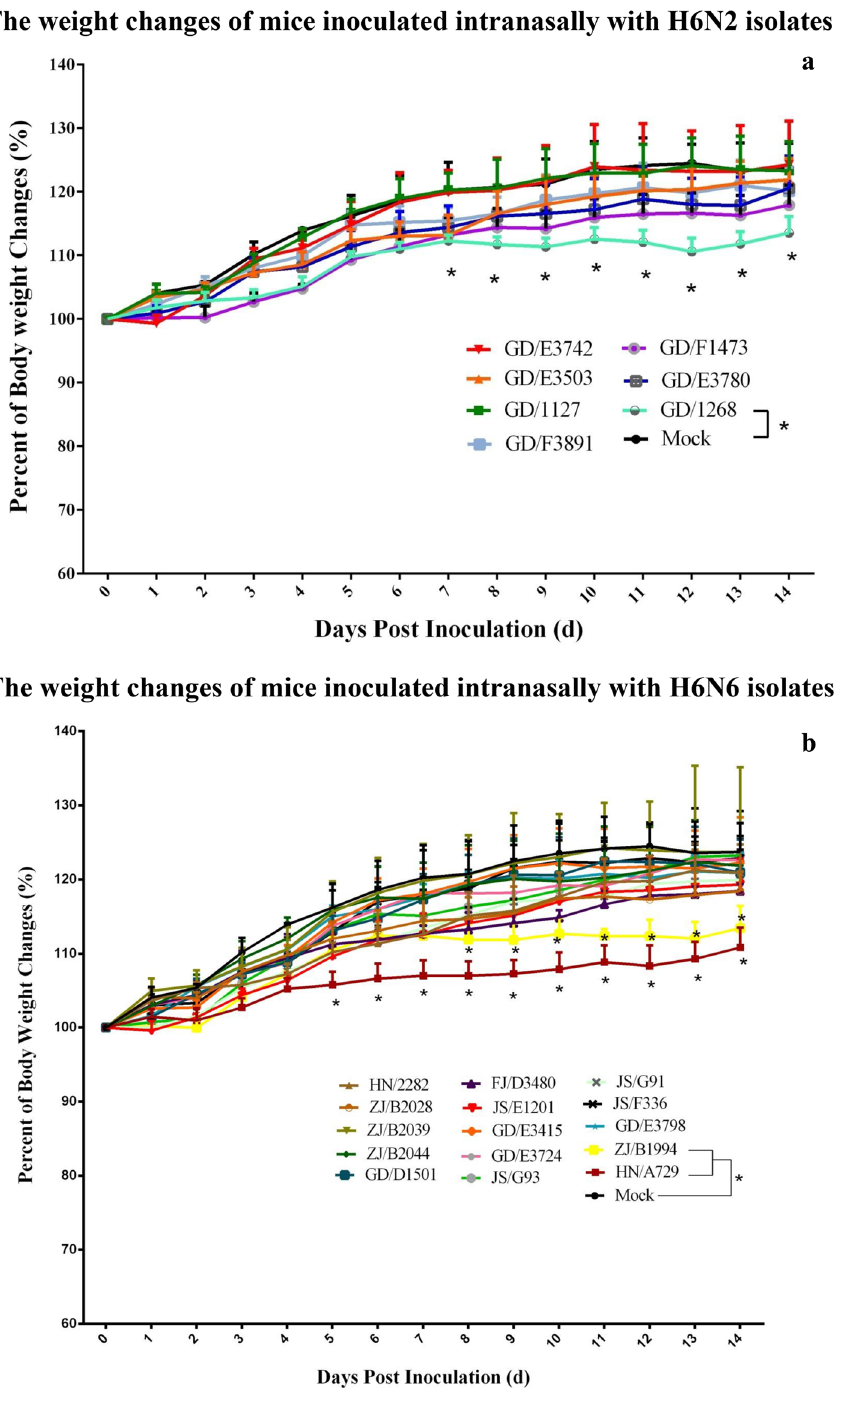
Figure 3. Bodyweight changes of BALB/c mice infected with the H6 AIVs. 4-week-old female BALB/c mice were inoculated i.n. with 10 6.0 EID 50 of virus in a volume of 30.0 μl. The body weight of 5 mice were measured daily until 14 dpi. Weight changes of the BALB/c mice infected with H6N2 (Fig. 3a) and H6N6 (Fig. 3b) were shown respectively. The data were graphed using the Prism 6.0 software (Vision 6.0, GraphPad Prism). Comparisons of the weight changes between two groups were determined by nonparametric t-tests using GraphPad. (*P < 0.05, **P < 0.01, ***P <